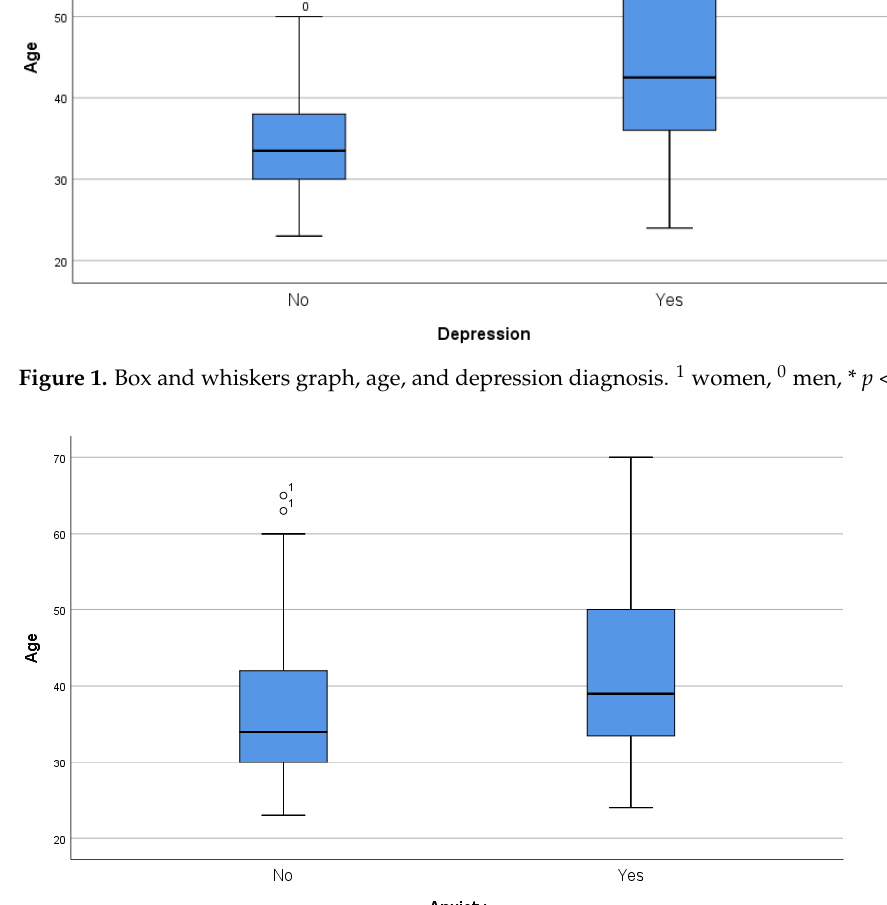
Figure 2. Box and whiskers graph, age, and anxiety diagnosis. 1 women, 0 men, * p < 0.05